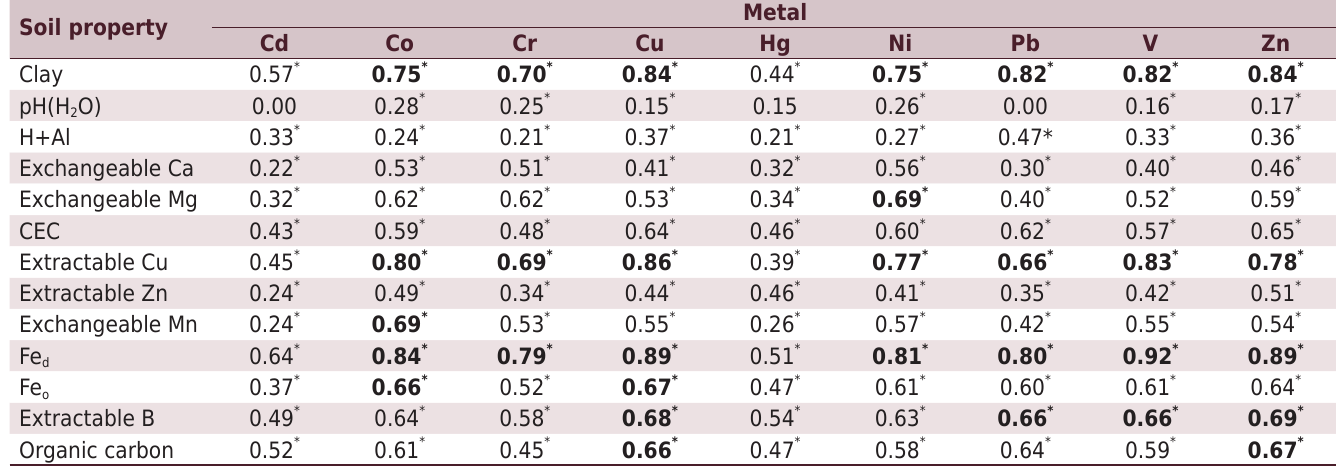
Table 6. Spearman correlation coefficients (r s ) between soil properties and metals. Correlation coefficients >0.65 are in bold Soil property